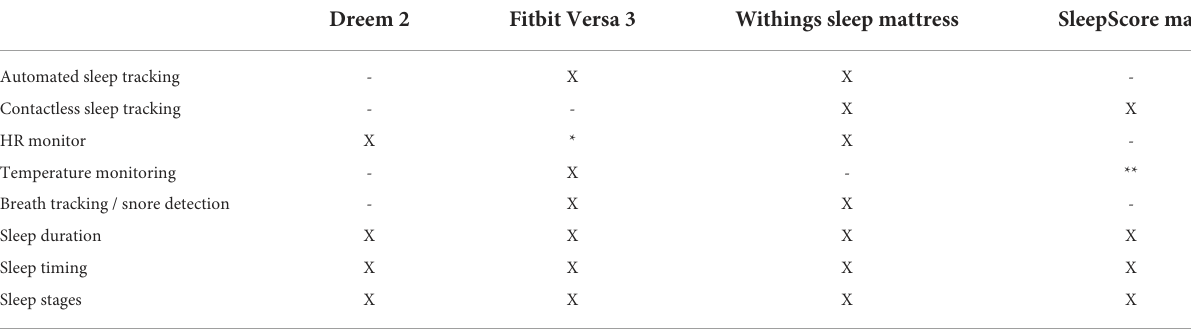
TABLE 1 Device capabilities related to sleep tracking.